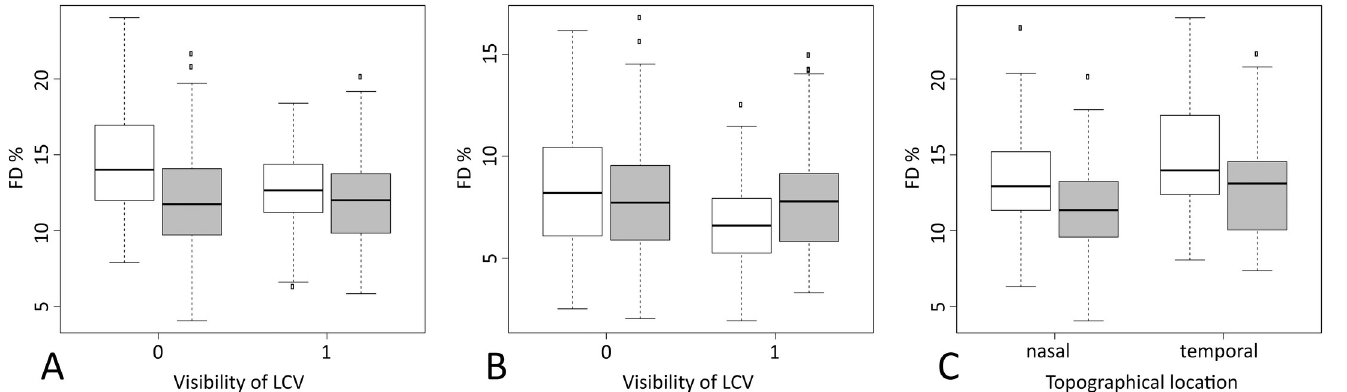
Fig 3. Impact of large choroidal vessels (LCV) and topographical orientation on percentage of flow deficit (FD%) values. In all three images (A-C) the intermediate age-related macular degeneration (iAMD) group is shown in white, the control group in gray. (A) Boxplots showing FD% values in sectors without (0) and with (1) visible LCV in the main setting using the standard Phansalkar radius setting of 15 pixels; (B) Boxplots showing FD% values in sectors without (0) and with (1) visible LCV in a setting using a Phansalkar radius of 4 pixels adjusted to the image size. (C) Boxplots showing FD% values in relation to their topographical location (nasal or